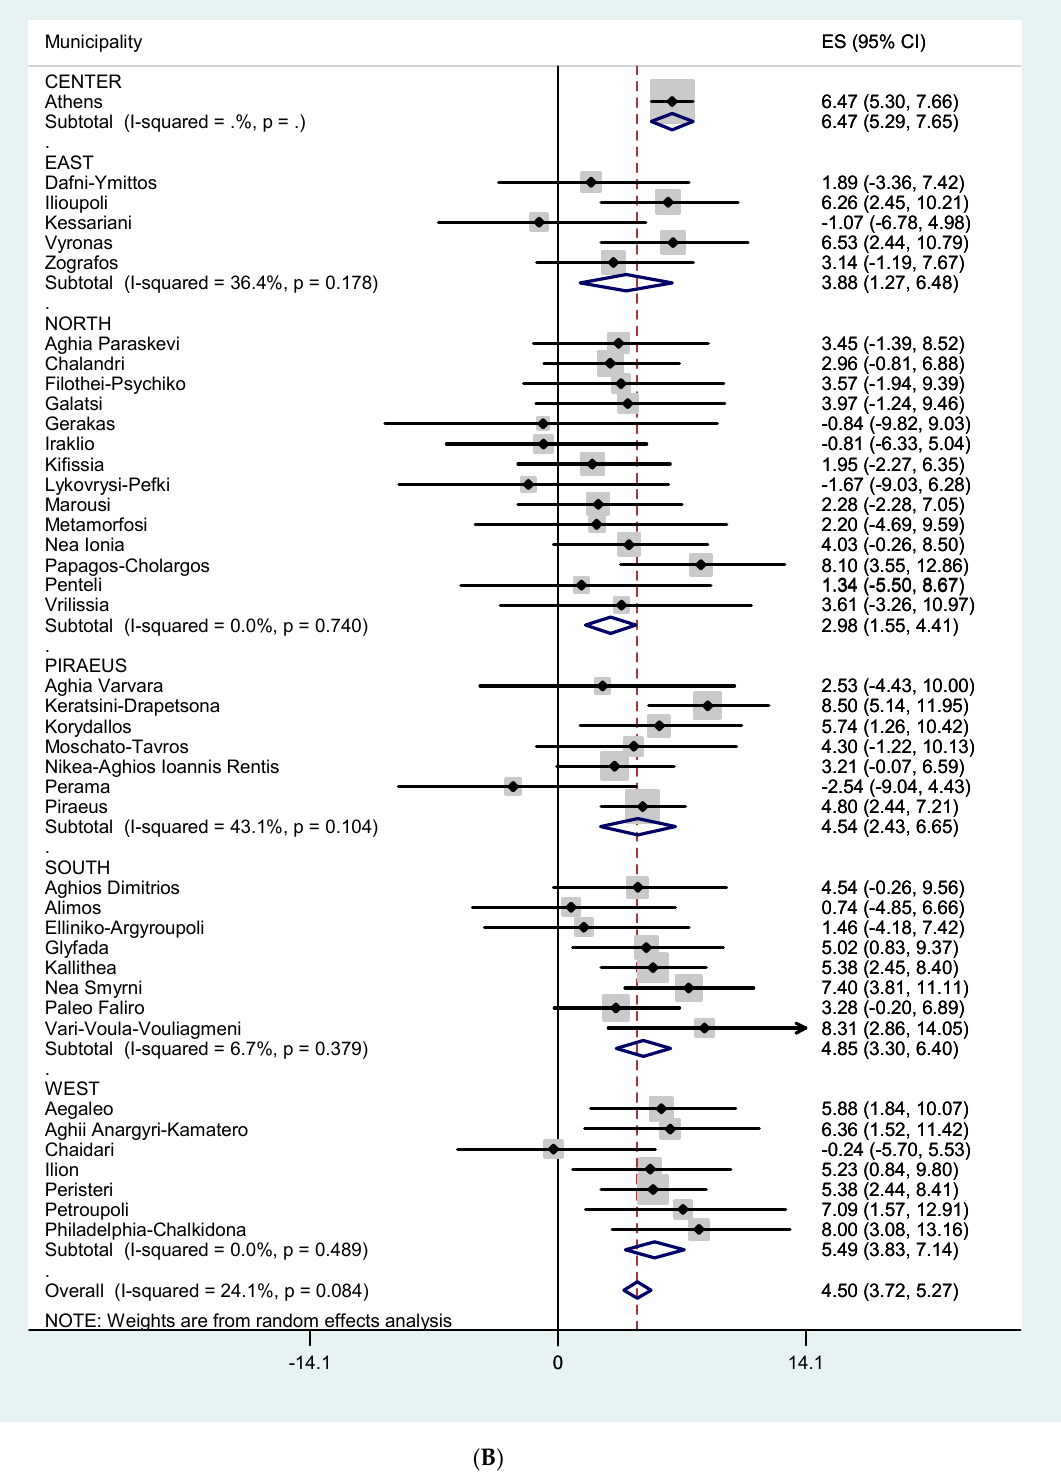
NOTE: Weights are from random effects analysis